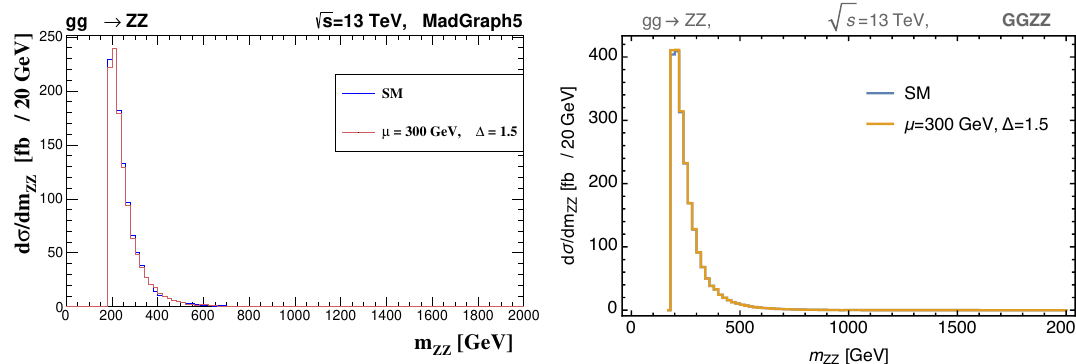
Figure 12. gg ! ZZ . The sum of the box and Higgs diagrams with the Z bosons on-shell.